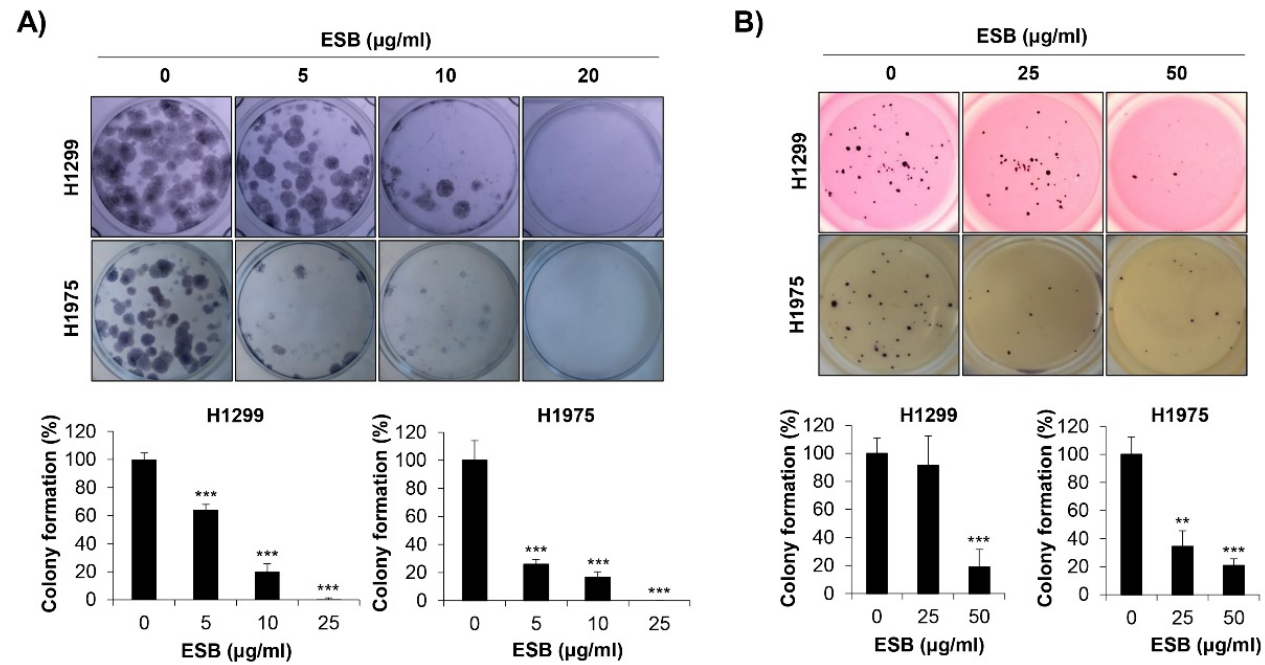
Figure 4. Effects of ESB on the colony formation of EGFR TKI-resistant human NSCLC cell lines. H1299 ( EGFR wildtype; EGFR TKI-resistant) and H1975 (acquired TKI-resistant) human NSCLC cell lines were seeded as a single cell suspension in 12-well plates ( A ) or soft agar ( B ) and treated with the indicated concentrations of ESB for 10–15 days. The colonies were photographed by a digital camera (upper panel), and the number of colonies was counted using ImageJ software (lower panel). The data are expressed as the mean ± SD of three independent experiments. Significance was determined by the Student’s t-test (** p < 0.01, *** p < 0.001 vs. untreated controls). ESB, ethanol extract of the root of Scutellaria baicalensis; NSCLC, non-small-cell lung cancer; EGFR TKI, Epidermal growth factor receptor tyrosine kinase inhibitor; SD, standard deviation.